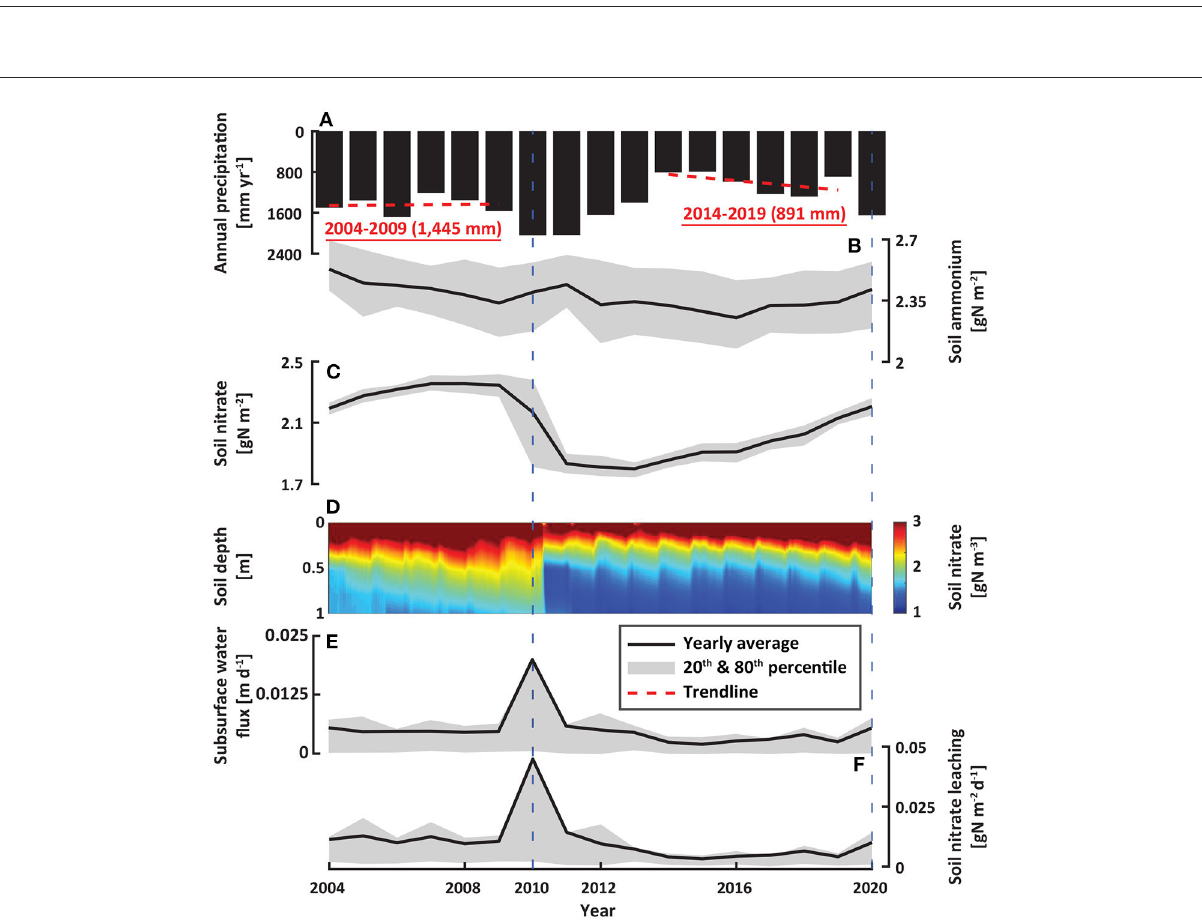
FIGURE6 The impacts of abrupt precipitation changes on soil inorganic nitrogen dynamics. (A) Observed annual precipitation, and modeled (B) soil ammonium, (C) soil nitrate, (D) soil nitrate profile, (E) subsurface water flux, and (F) soil nitrate leaching at a depth of 1 m. Soil inorganic nitrogen dynamics were analyzed to a depth of 1 m. The shaded gray areas in (B,C,E) indicate the 20th and 80th percentiles that represent their variations in a given year. Red in (A) represents linear trend lines. Blue dotted lines represent 2010 and 2020, respectively, for visualization